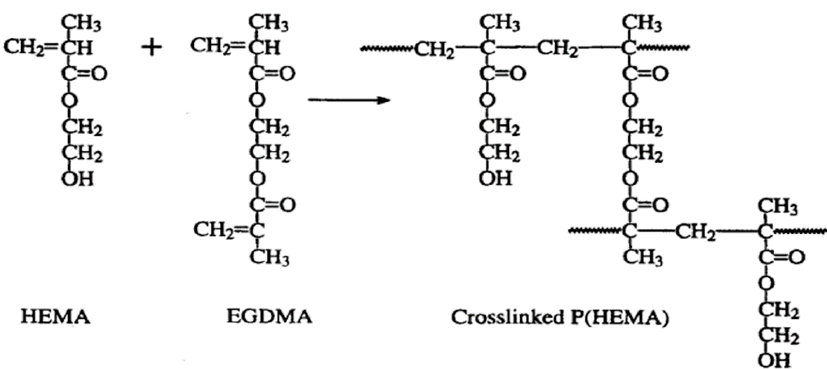
Figure 1. A schematic representing the synthesis of pHEMA hydrogel from copolymerization of HEMA with other co-monomers, (EGDMA, ethylene glycol dimethacrylate). Reprinted from [27] with permission from Taylor & Francis.